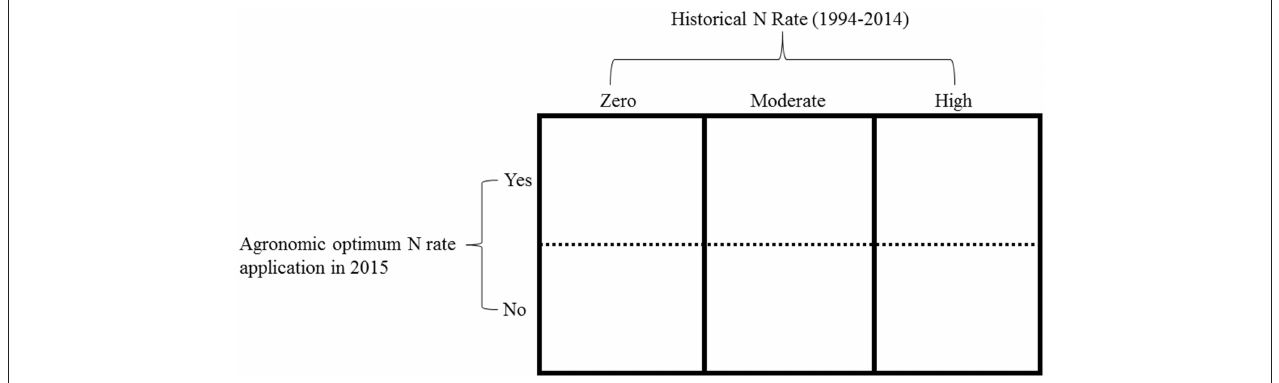
FIGURE 1 | An example of one replicate experimental block. Main plot (columns): the historical N rates, which included, zero (0kg N ha − 1 ), moderate (202 and 224kg N ha − 1 at central and southern sites, respectively) and high (269kg N ha − 1 ). The split plot (rows): the agronomic optimum N rate (AONR) and zero N applied in 2015. similar to that of soils from zero N plots that received the AONR in the field ( ∼ 23 mg N kg − 1 soil at central site, and ∼ 50 mg N kg − 1 soil at southern site); the other subsample